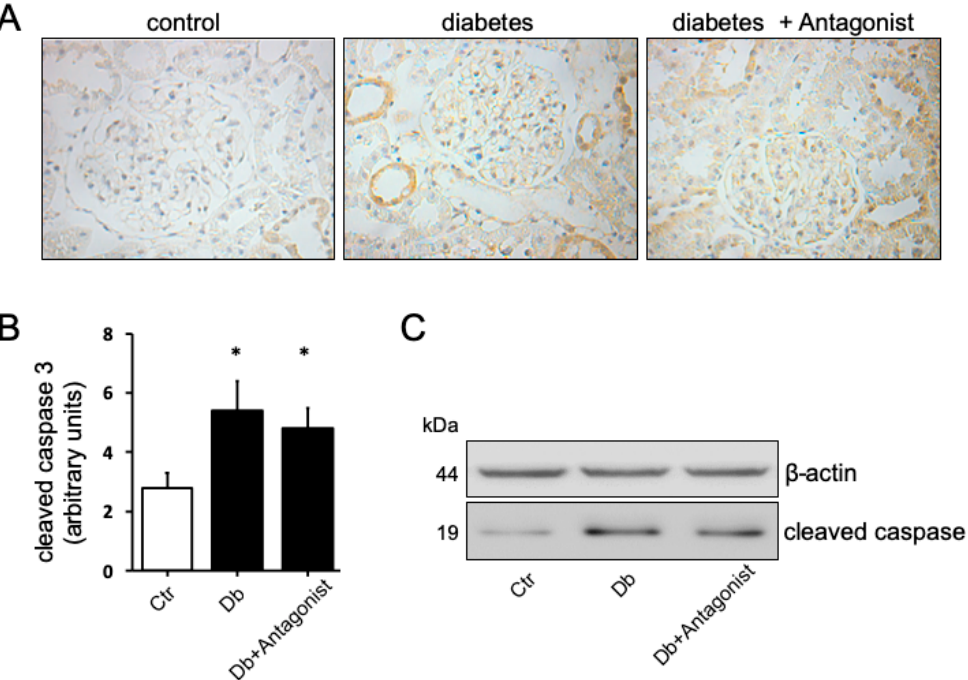
Figure 5. The ADORA3 antagonism does not affects caspase 3 activation in the kidney of diabetic rats. The levels of cleaved caspase 3 in the kidney sections from experimental groups were assayed by immunohistochemistry. Representative images of cleaved caspase 3 distribution in kidney cortex are shown in ( A ). Original magnification 400 × . The graph in ( B ) depicts the quantitative analysis of caspase 3 staining on 10 microscopic fields per slice from animals belonging to each experimental group using the UN-SCANIT 2.0 software. n = 5 in each group. *, p < 0.05 vs. control group. In ( C ) is shown the western blot analysis of cleaved caspase 3 in total kidney protein extracts from experimental groups. β -actin was used as the loading control.